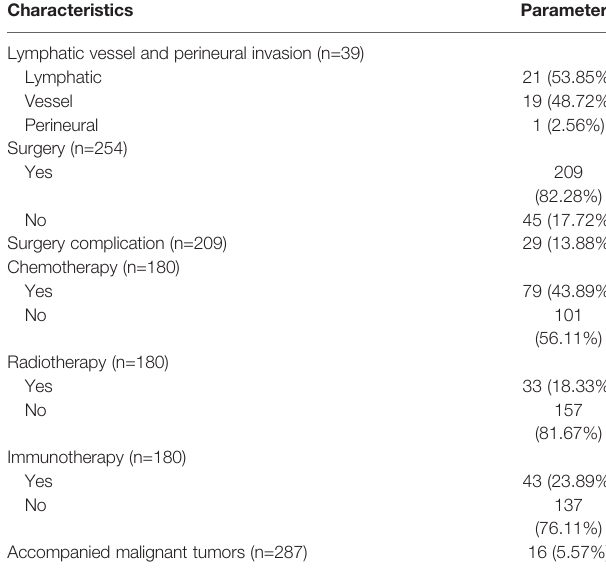
TABLE 2 | Clinicalpathological characteristics of 287 cases of esophageal